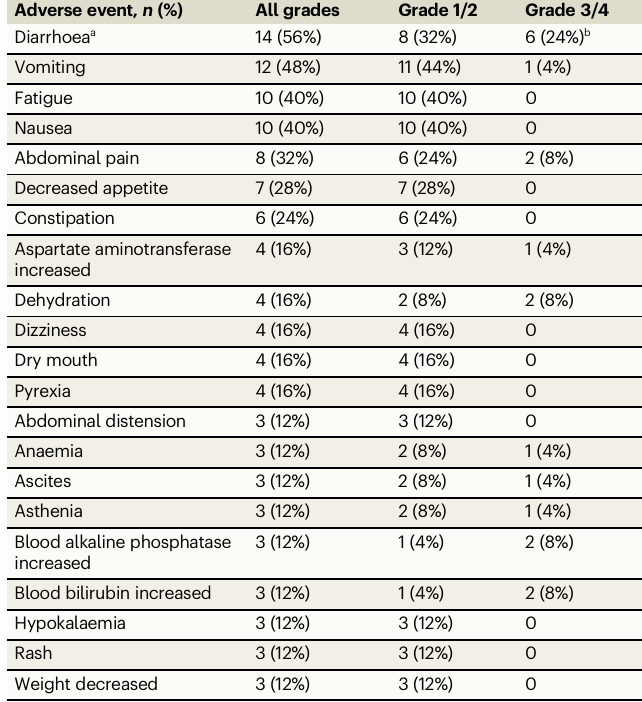
Table 2 | Activity summary